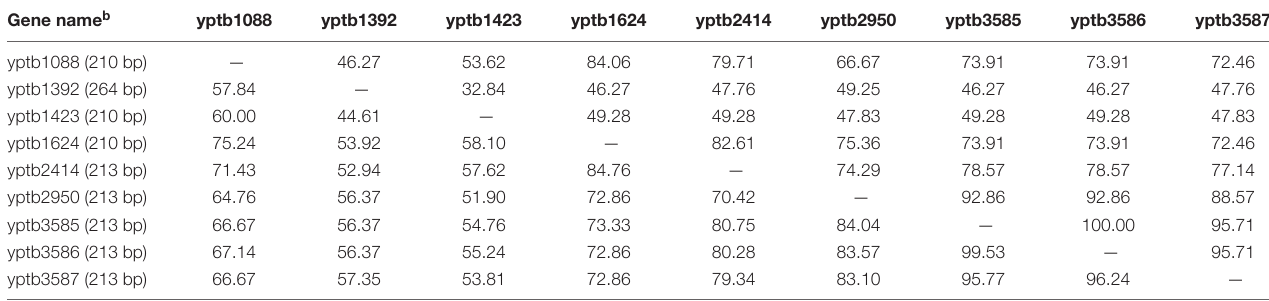
a Translated amino acid sequence comparisons above the diagonal and nucleotide sequence comparisons below the diagonal. Alignments were calculated using Clustal Omega v.1.2.1. Nucleotide and amino acid sequences were derived from The Kyoto Encyclopedia of Genes and Genomes (Kanehisa et al., 2016). b Gene length in